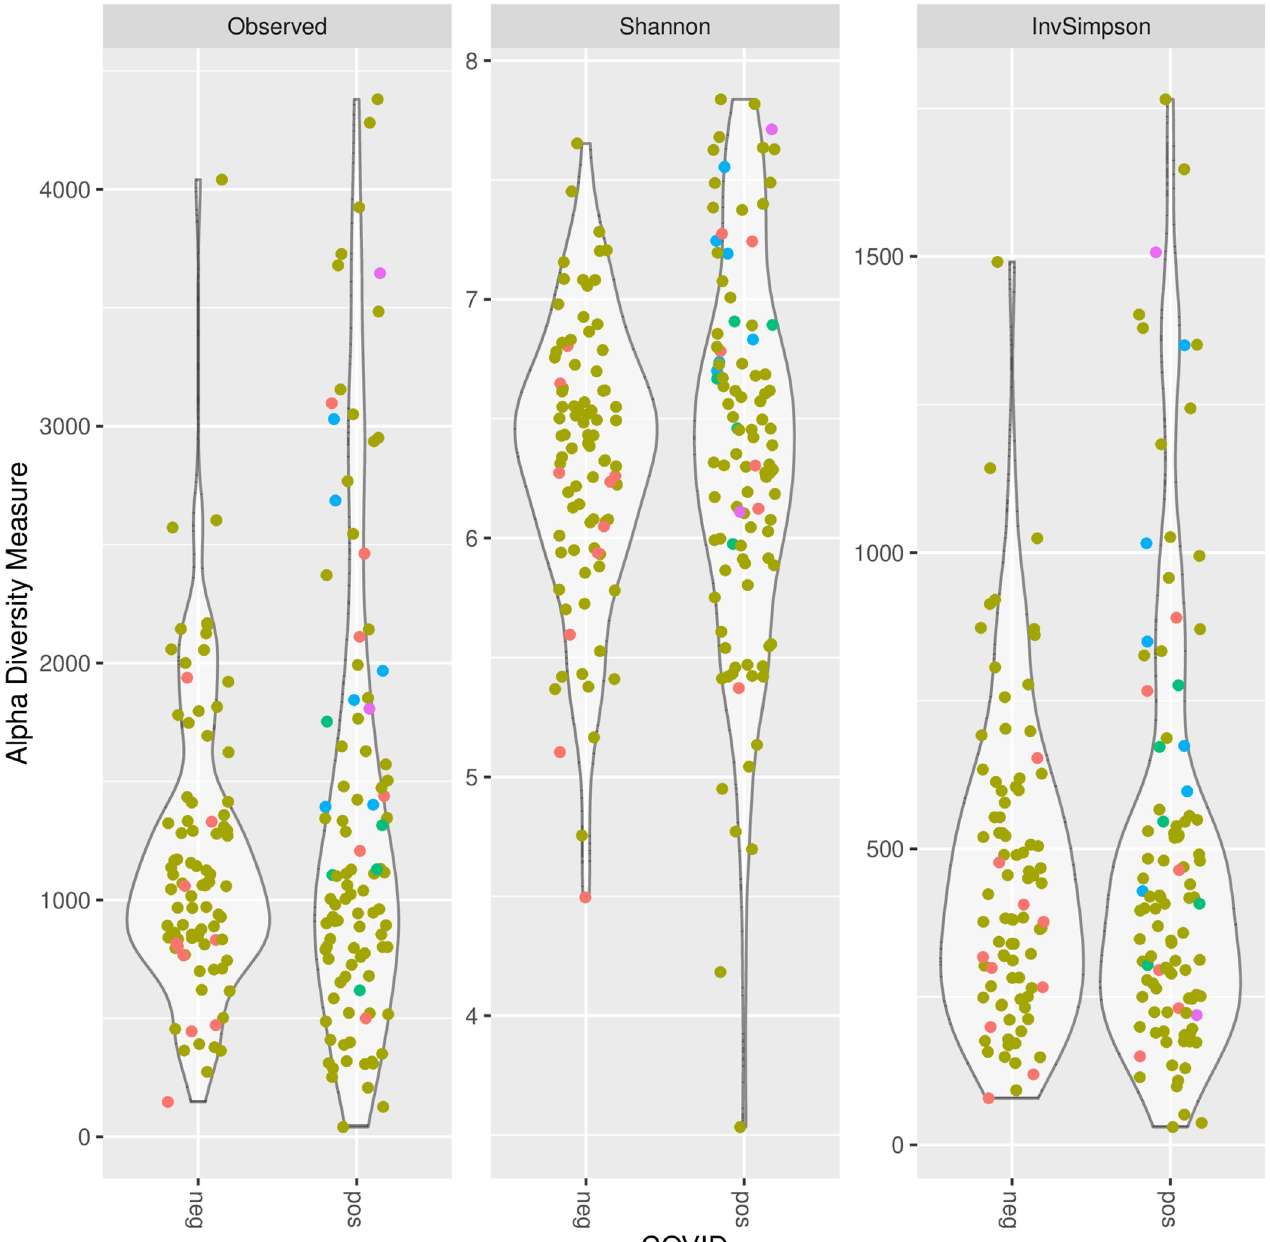
Fig 5. Alpha diversity analysis from 16S rRNA sequencing data. Violin plots comparing observed ASV count, Shannon index, and inverse Simpson index for SARS-CoV-2 negative and SARS-CoV-2 positive samples. P-values from Welch’s two sample t-test are displayed. https://doi.org/10.1371/journal.pone.0278543.g005 for viruses and bacteria. Among these 78 samples, 4 samples were nose/throat swabs (and neg- ative for SARS-CoV-2 by PCR), the other 74 were all NP samples (9 positive for SARS-CoV-2 and 65 negative for SARS-CoV-2). These samples were collected throughout February to July of 2020 and were not from a specific month. It is likely that there was insufficient microbial or viral DNA in these samples, or the viral and bacterial concentrations were below the detection limit of the LLMDA. Previous evaluation of the 4-plex version of the LLMDA showed that the